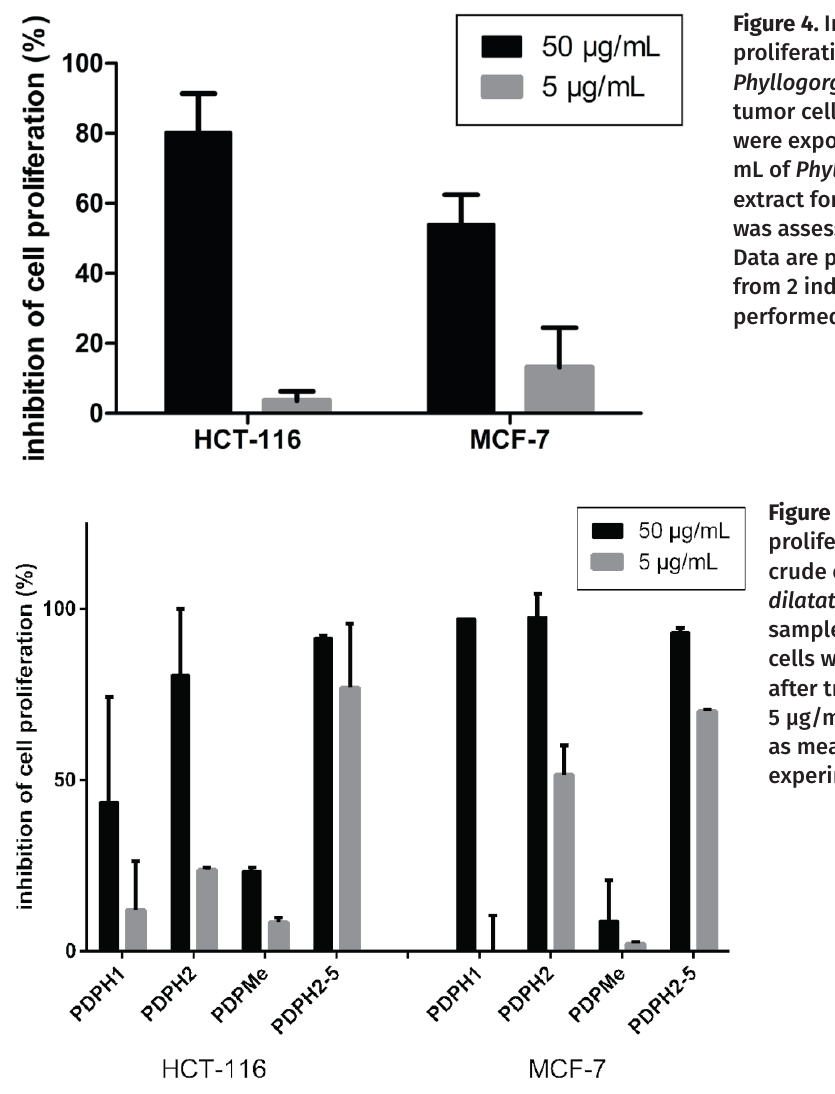
Figure 4. Inhibition of cell proliferation by the crude extract of Phyllogorgia dilatata . Two human tumor cell lines, HCT-116 and MCF-7, were exposed to 50 µg/mL and 5 µg/ mL of Phyllogorgia dilatata crude extract for 72 h. Cell proliferation was assessed by the MTT assay. Data are presented as mean ± SEM from 2 independent experiments performed in duplicate.